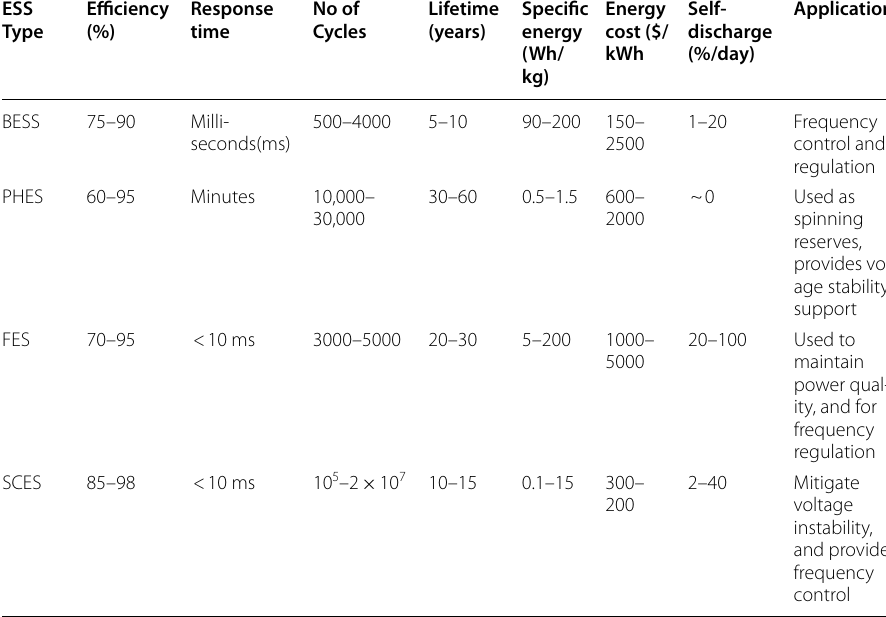
Table 3 Generic characteristics of energy storage systems